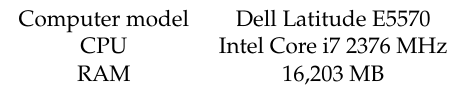
Table A1. Hardware specifications for the numerical experiments.